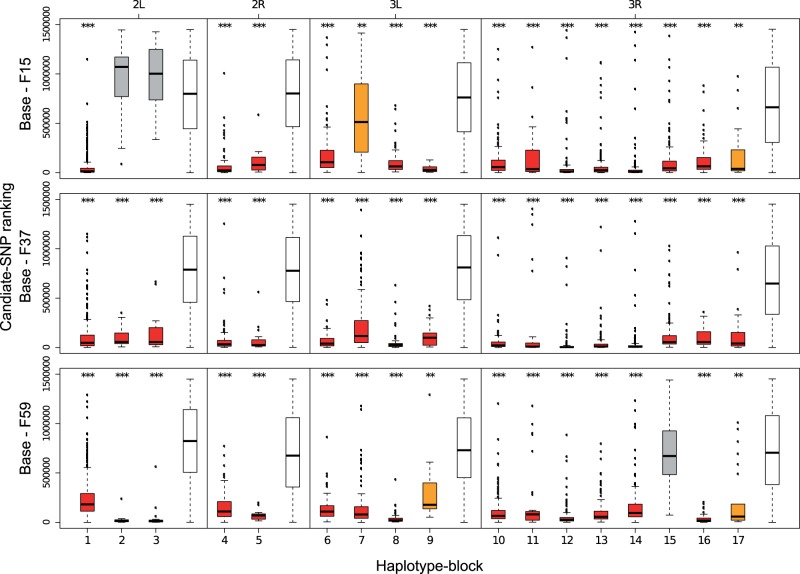
Enrichment of candidate SNPs in haplotype-blocks. To test whether haplotype-block-specific SNPs are among the most significant SNPs in the Pool-Seq data, we plot their rank among all SNPs tested with the Pool-Seq data. Three comparisons are shown: base–F15, base–F37, and base–F59, respectively. For comparison, the rank of all singletons on the same chromosome arm that are not part of a haplotype-block is shown as white boxplots. Boxplots for haplotype-block singletons are shaded according to their differentiation to the nonhaplotype-block background for the respective chromosome arm (Mann–Whitney U test): ***FDR < 10−10, **FDR < 10−3, or no significant differentiation. Singletons in all 17 haplotype-blocks show candidate enrichment for at least one time point. Enrichment over time differs between the blocks.